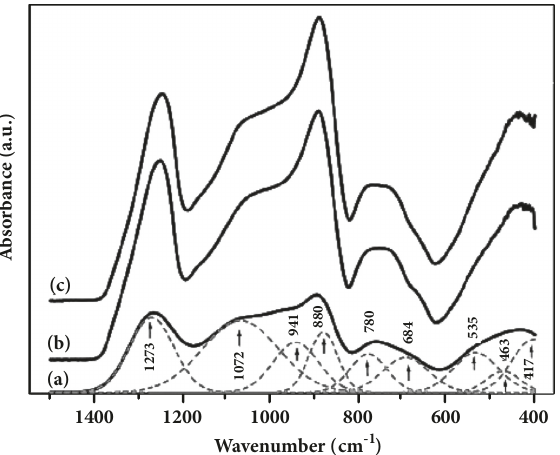
Figure 10: FT-infrared absorption spectra of (a) 0.5%, (b) 2%, and (c) 5% Sm 2 O 3 -doped glasses.